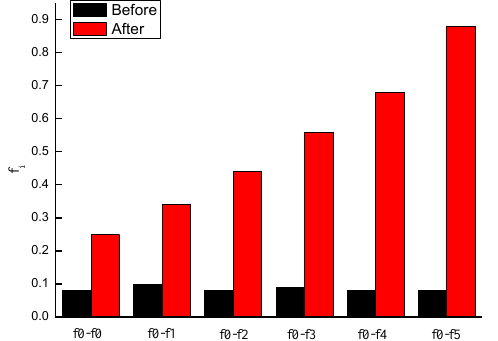
Figure 5. Comparison of roughness before and after interface processing.